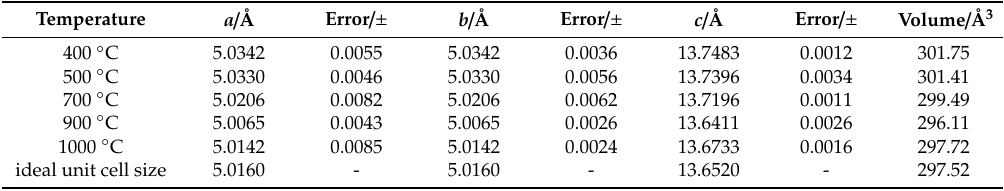
Table 2. Unit cell parameters of Fe 2 O 3 in nickel slag samples after oxidation at 400–1000 ◦